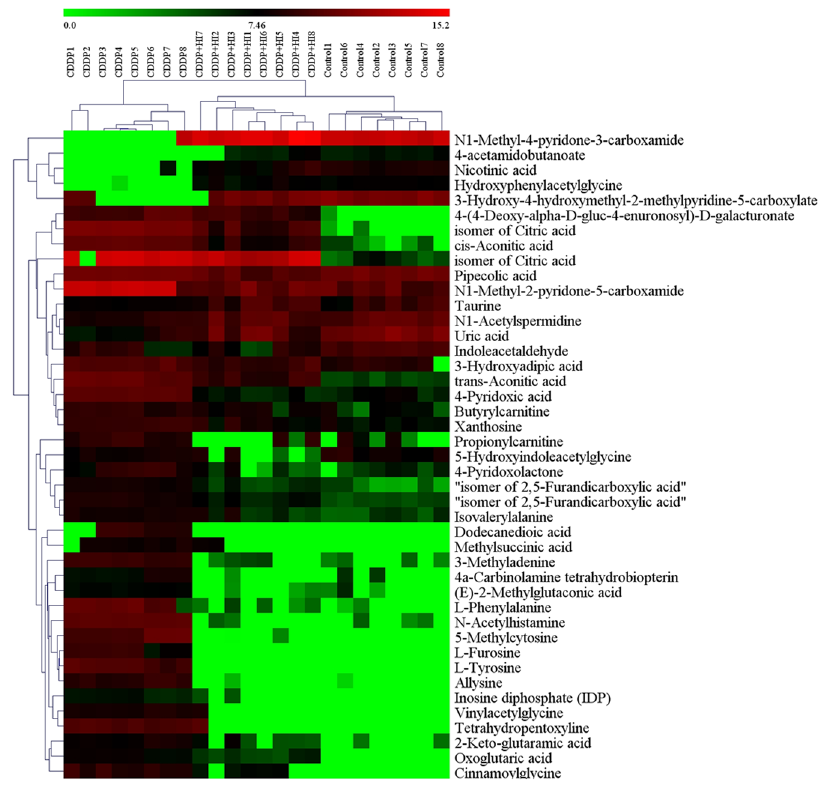
Figure 6. The heatmap and hierarchical cluster analysis of relative contents of 43 potential